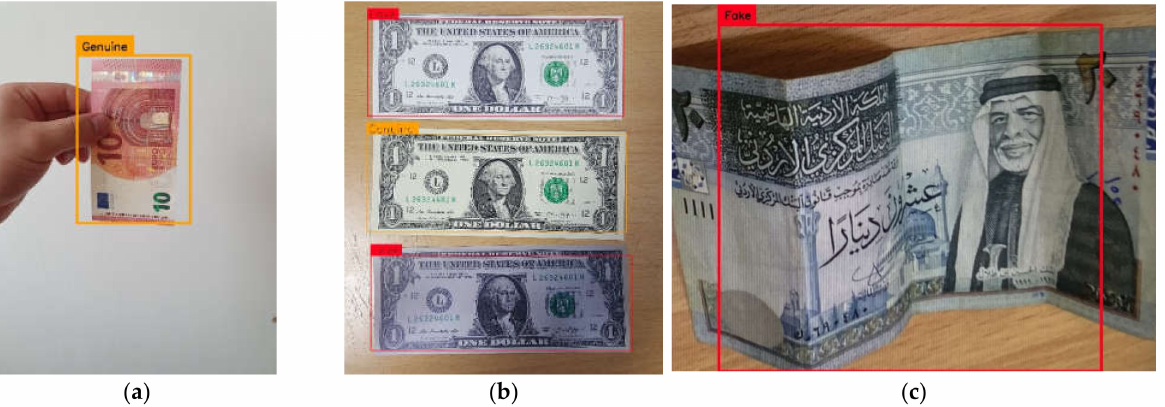
Figure 17. Correctly detected cases of ( a ) a genuine EUR note; ( b ) (from top to bottom) scanner- reproduced fake, genuine, and smartphone-reproduced fake USD notes; and ( c ) a fake JOD note using the models trained on the KRW dataset.